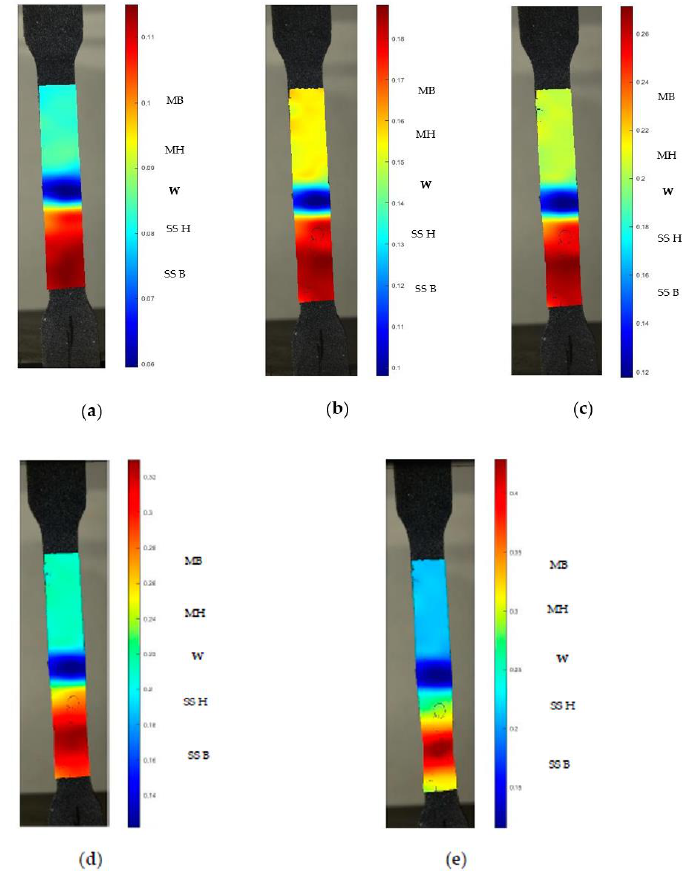
Figure 9. Strain distribution across weld specimen during a tensile test for CT specimen: ( a ) stage 1; ( b ) stage 2; ( c ) stage 3; ( d ) stage 4; ( e ) stage 5; MB–Monel 400 Base, MH–Monel 400 HAZ, W–Weld, SS H–SS 316L HAZ, SS B–SS 316L Base. Table 5. Strain distribution for CT specimen in each stage. Local Strain